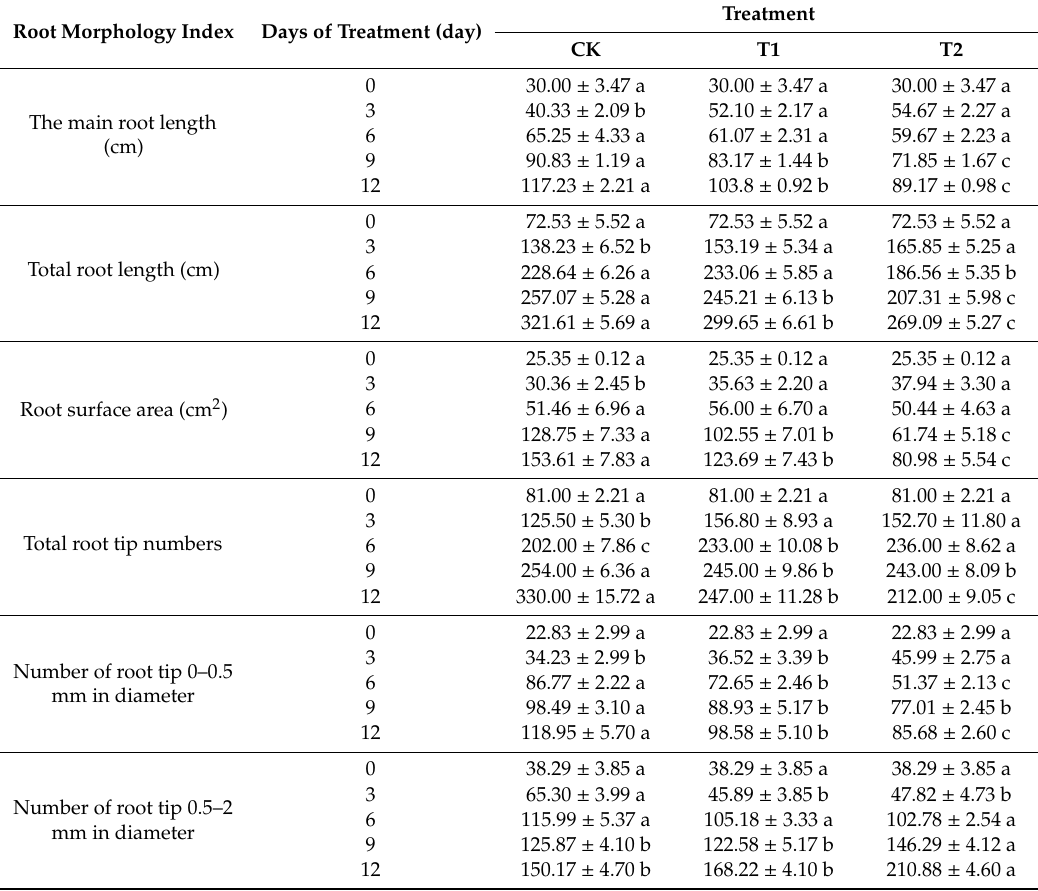
Table 1. Root morphology index of oriental melon under elevated root-zone CO 2